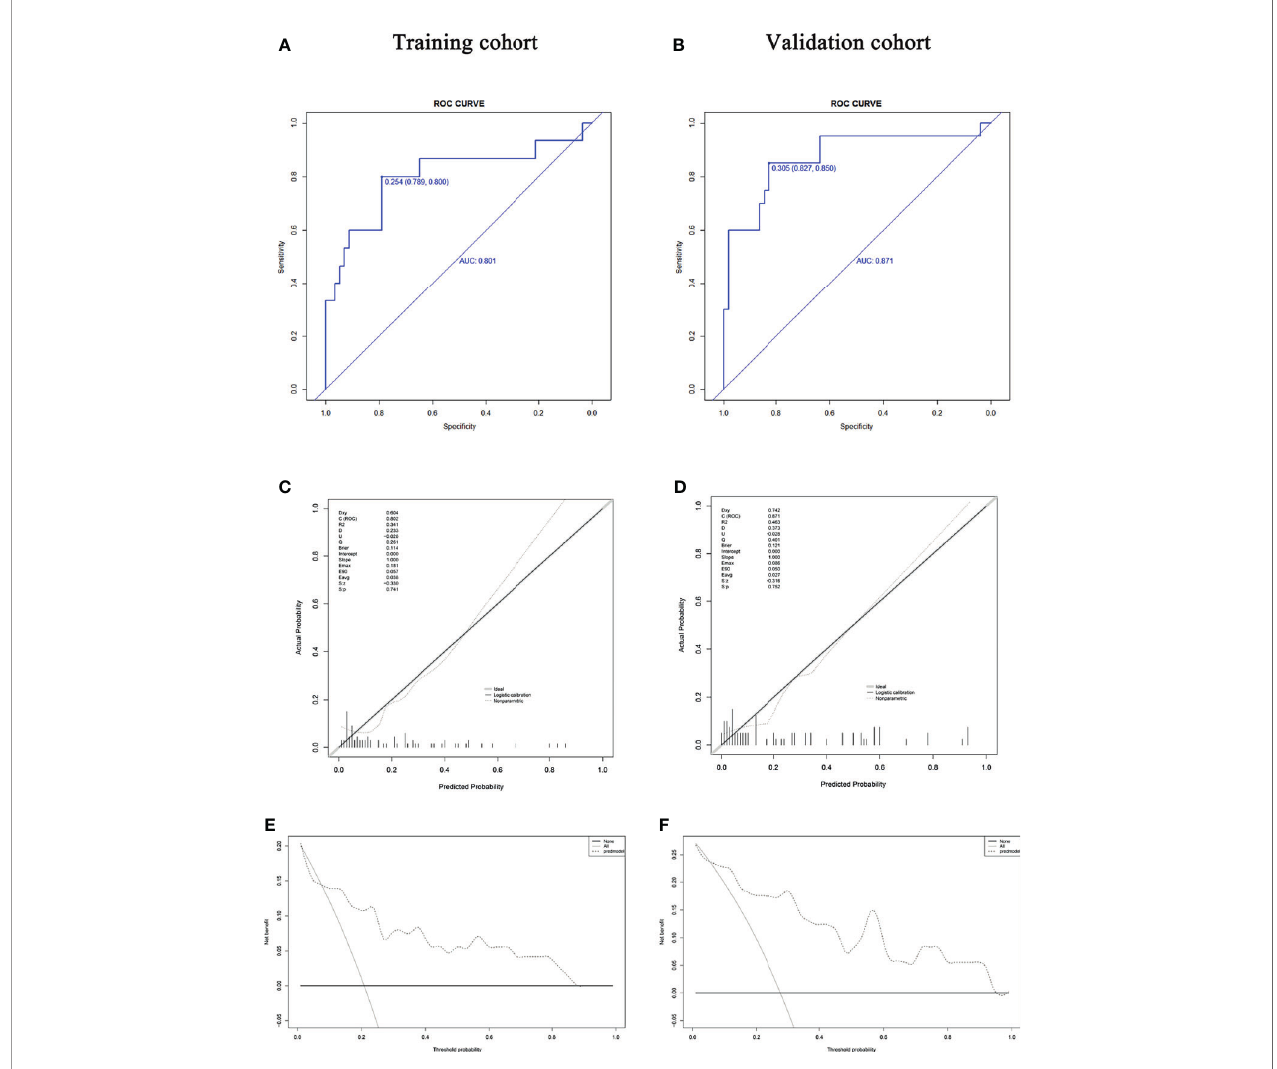
FIGURE 3 | The diagnostic value, concordance, and clinical relevance of the diagnostic model. (A, B) The AUC indicates the discriminatory performance of the diagnostic model in the training and validation cohorts. (C, D) Calibration test of the diagnostic model in the training and validation cohorts. The fi tting curve by regression analysis (black solid line) approximates the standard curve (gray line), with no signi fi cant difference (P = 0.741 and P = 0.752, respectively). (E, F) DCA of the training and validation cohorts. DCA showed more bene fi t from using the diagnostic prediction model if the threshold probability was in the ranges of ≤ 2% and 8-87% in the training cohort and a higher overall net bene fi t if the threshold probability was in the ranges of ≤ 1% and 6-94% in the internal validation cohort. AUC, area under the curve; DCA, decision curve